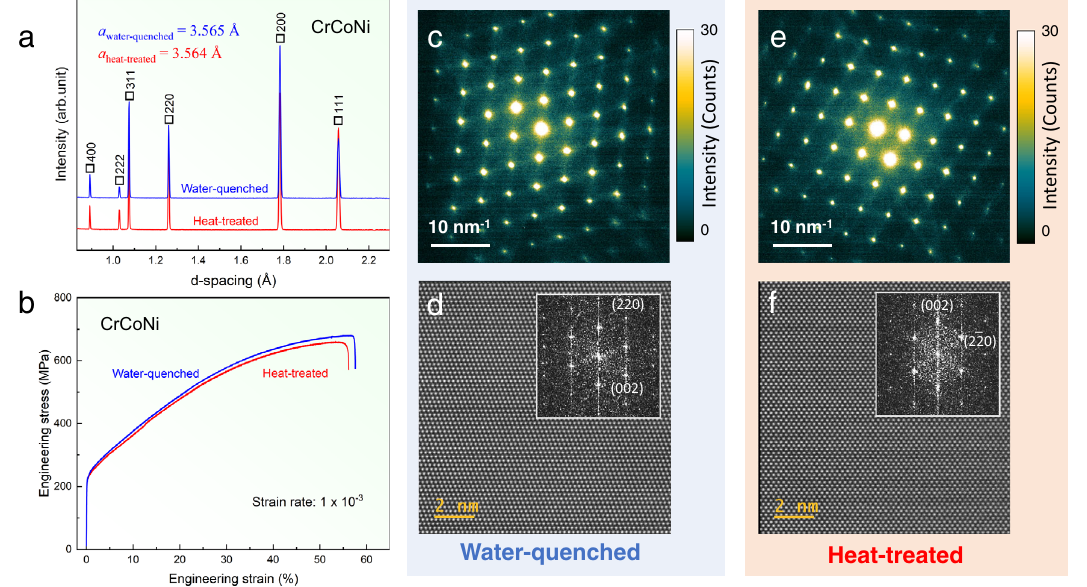
Fig. 1 | Characterization of the CrCoNi samples prepared by water-quench and heat-treatment.a Neutron-diffractionpatterns,showingthepresenceofthesingle fccphaseinbothsamples. b Themeasuredtensilestress-strainuptofractureatthe strain rate of 1×10 − 3 s − 1 . c , e Energy- fi ltered electron-diffraction patterns and